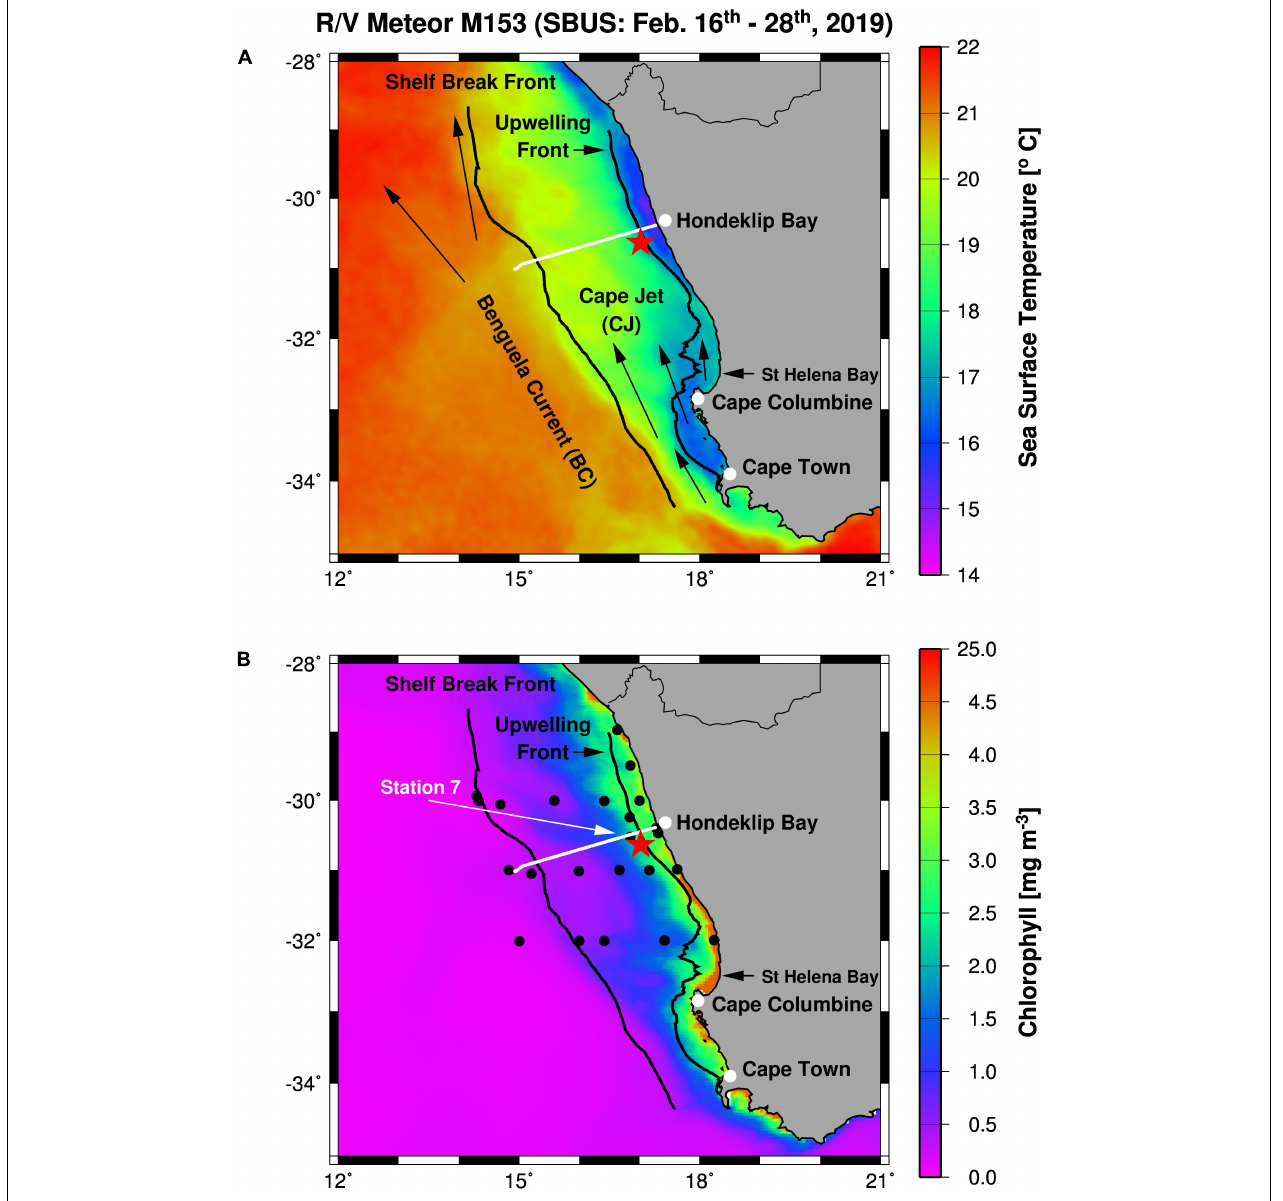
FIGURE 1 | Working area (A) and station map (B) showing the mooring site (red star), and the TRIAXUS transect (white line) as well as satellite-derived sea surface temperatures (A) and chlorophyll-a concentrations (B) averaged for the period of the cruise M153. Furthermore, arrows indicate the Benguela Current and the Cape Jet (A) and the black lines mark the 1,000 m depth contour line and the 17.2 ◦ C isotherm in (A,B) . The Shelf Break Front ( ∼ 20 ◦ C isotherm) almost follows the 1,000 m depth contour line whereas the 17.2 ◦ C isotherm defines the Upwelling Front. Black circles show CTD stations while the white arrow highlight the location of Station